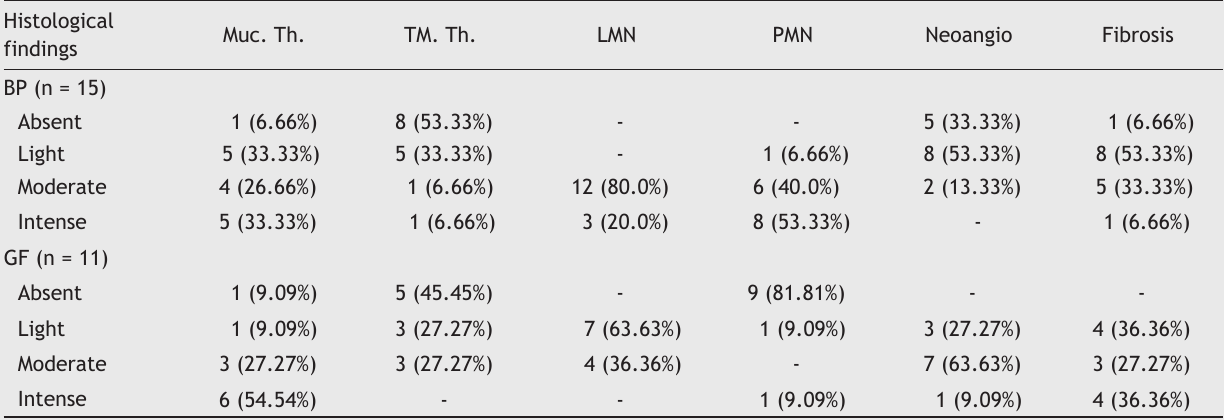
Table 2 Histological findings in the tympanic bulla of rats after 3 months of the experiment (T2). Histological Muc. findings